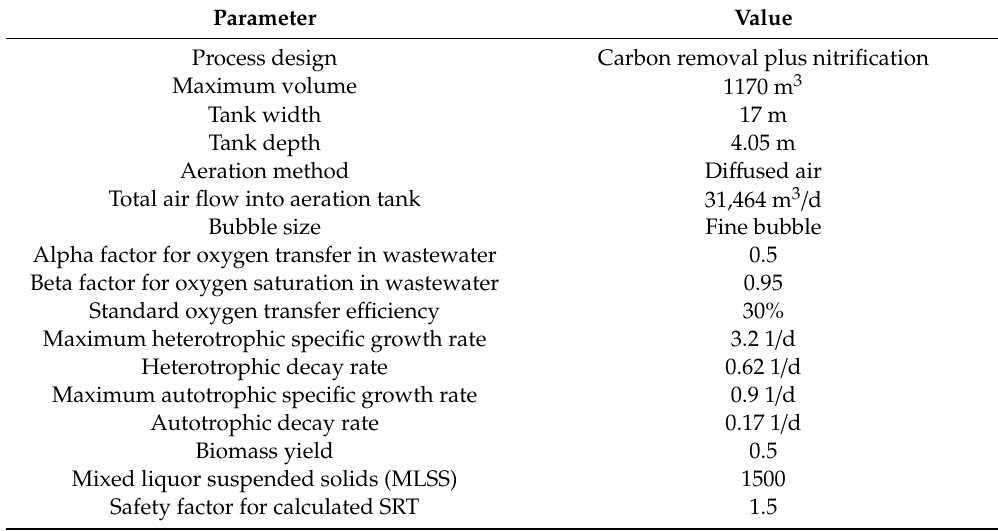
Table 2. The characteristics of CAS process parameters.